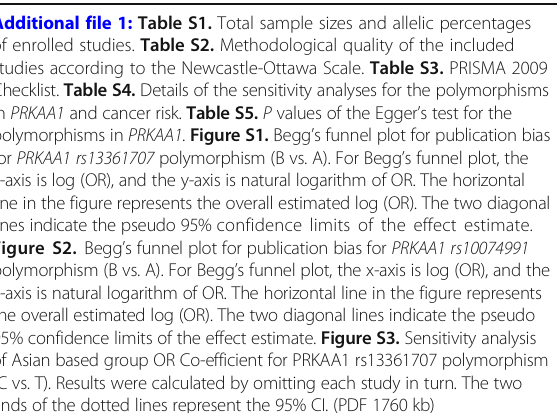
Additional file 1: Table S1. Total sample sizes and allelic percentages of enrolled studies. Table S2. Methodological quality of the included studies according to the Newcastle-Ottawa Scale. Table S3. PRISMA 2009 Checklist. Table S4. Details of the sensitivity analyses for the polymorphisms in PRKAA1 and cancer risk. Table S5. P values of the Egger ’ s test for the polymorphisms in PRKAA1 . Figure S1. Begg ’ s funnel plot for publication bias for PRKAA1 rs13361707 polymorphism (B vs. A). For Begg ’ s funnel plot, the x-axis is log (OR), and the y-axis is natural logarithm of OR. The horizontal line in the figure represents the overall estimated log (OR). The two diagonal lines indicate the pseudo 95% confidence limits of the effect estimate. Figure S2. Begg ’ s funnel plot for publication bias for PRKAA1 rs10074991 polymorphism (B vs. A). For Begg ’ s funnel plot, the x-axis is log (OR), and the y-axis is natural logarithm of OR. The horizontal line in the figure represents the overall estimated log (OR). The two diagonal lines indicate the pseudo 95% confidence limits of the effect estimate. Figure S3. Sensitivity analysis of Asian based group OR Co-efficient for PRKAA1 rs13361707 polymorphism (C vs. T). Results were calculated by omitting each study in turn. The two ends of the dotted lines represent the 95% CI. (PDF 1760